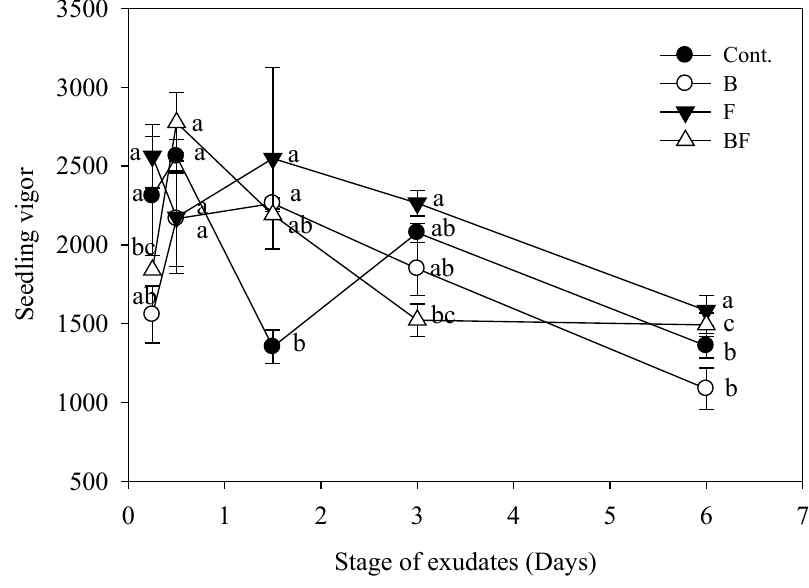
Figure 4: Change in lettuce seedling vigor with the application of biofilm exudates harvested at different time intervals. Maximum vigor was shown by seedlings treated from 0.5 days old fungal-bacterial biofilm